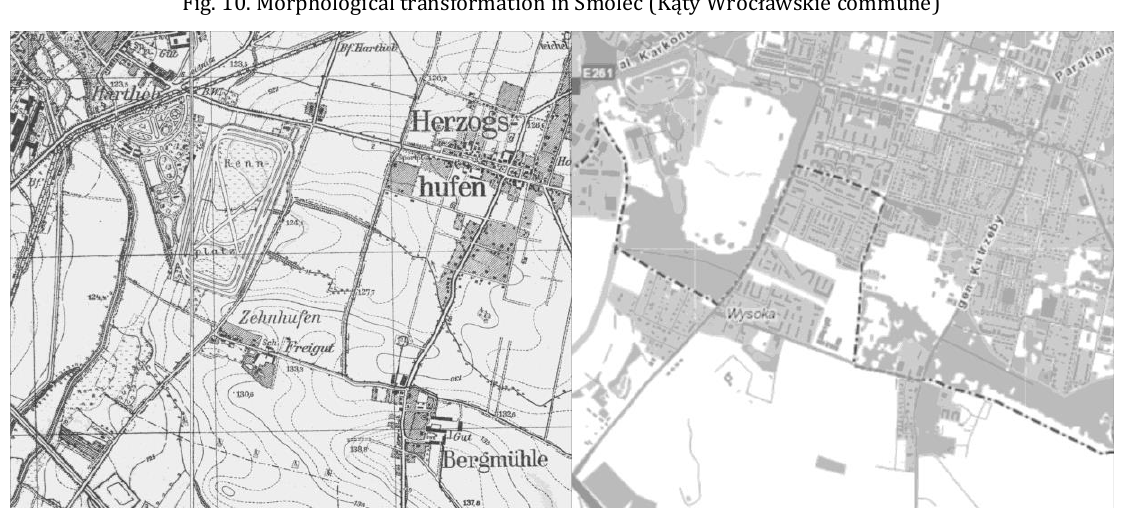
Fig. 11. Morphological transformation in Wysoka (Kobierzyce